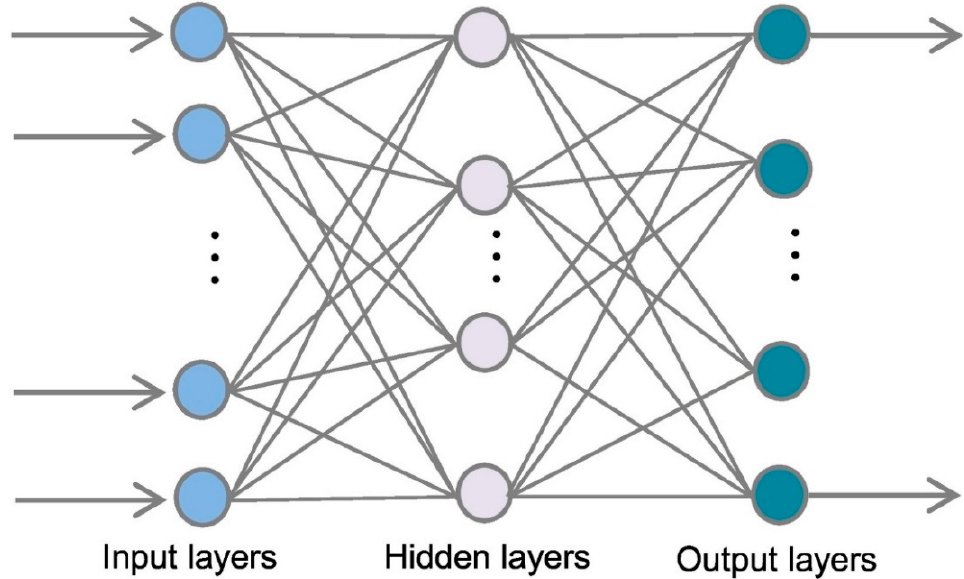
Figure 5. Sequence of a multi-layer perceptron neural network modeling process. Reprinted/adapted with permission from